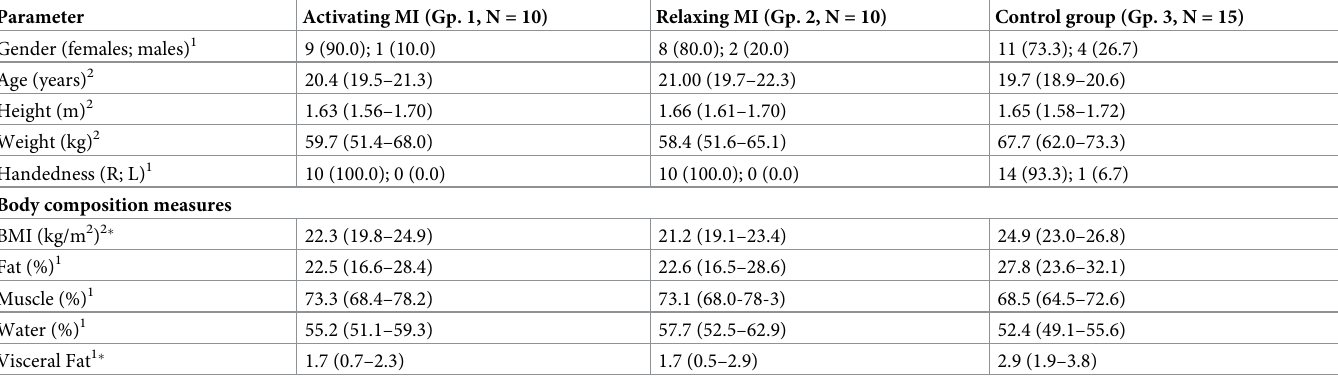
Table 1. Demographic characteristics and body